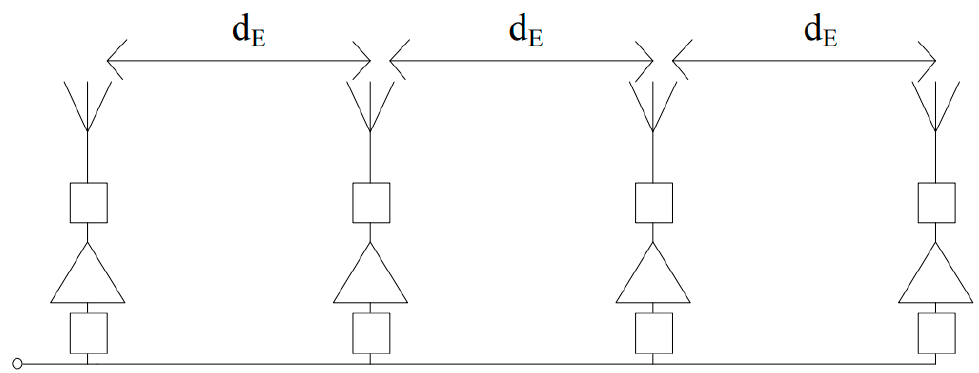
Figure 9. Series-fed active antenna array [47].